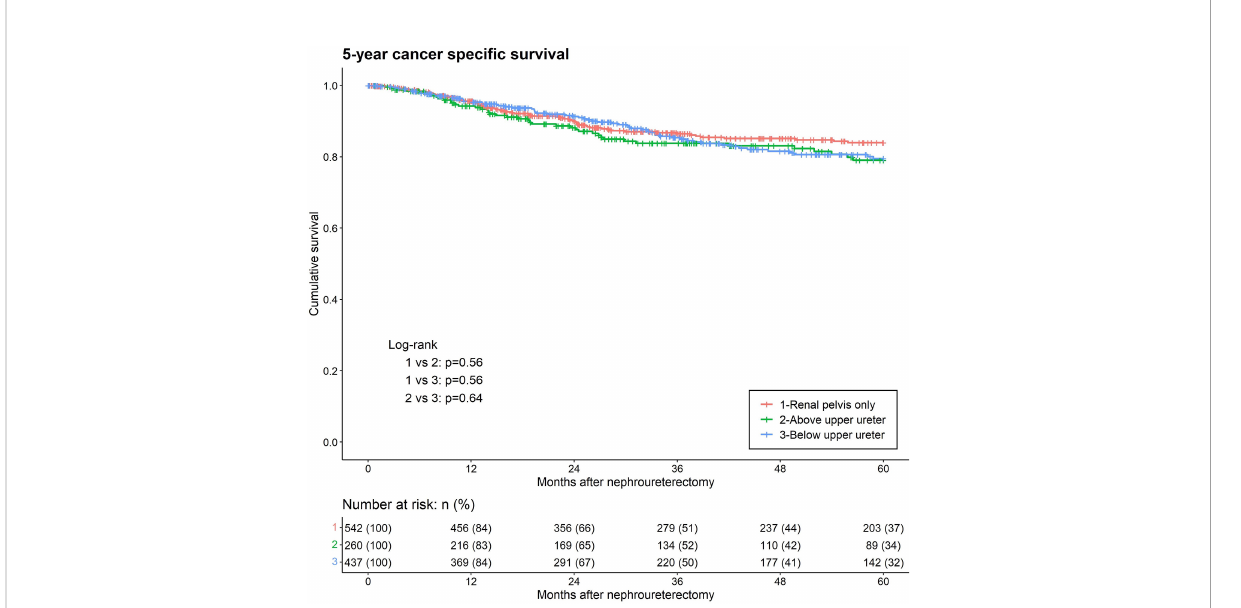
FIGURE 4 Kaplan-Meier analyses for 5-year cancer-speci fi c survival strati fi ed by the lowest level of tumor involvement among patients with upper tract urothelial carcinoma following radical